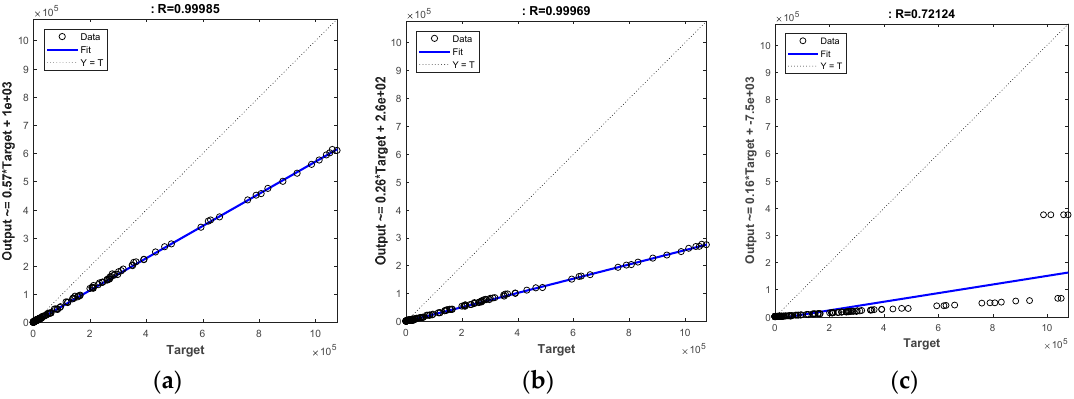
Figure 20. Coefficient of determination between original resolution (L) and M ( a ); S ( b ) and XS ( c ) resolutions.